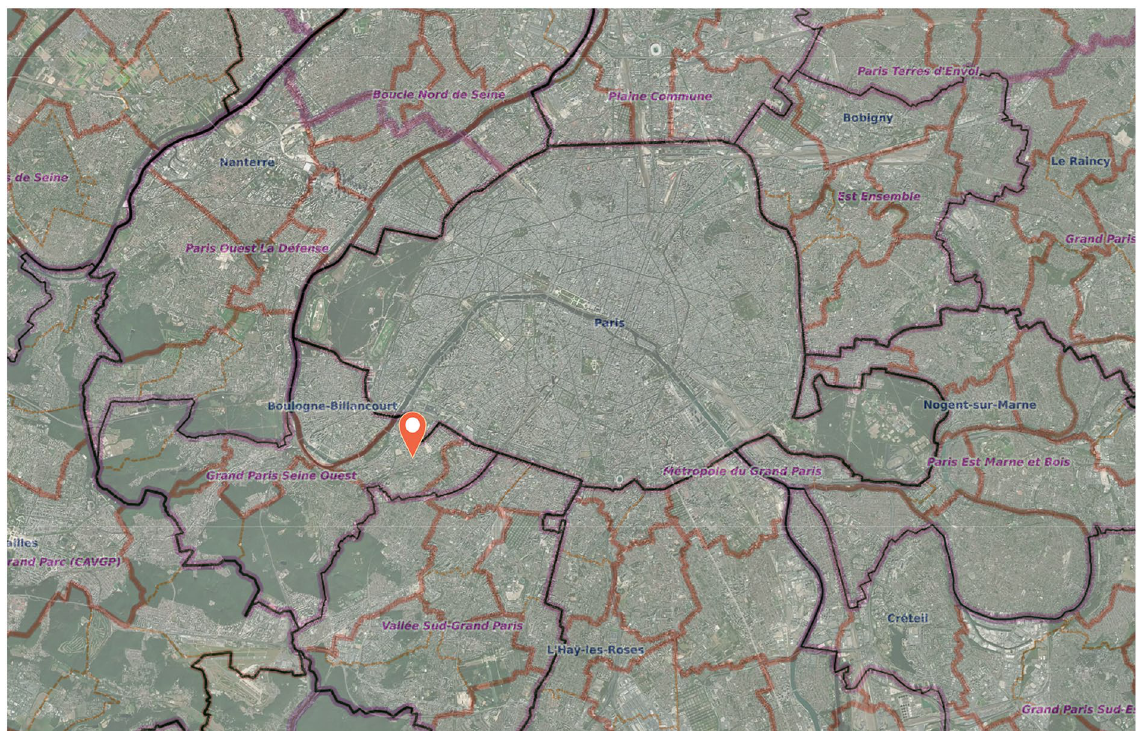
Fig. 1 Localisation of the municipality of Issy-les-Moulineaux. Source: Authors elaboration from DATA ISSY.COM—Municipality of